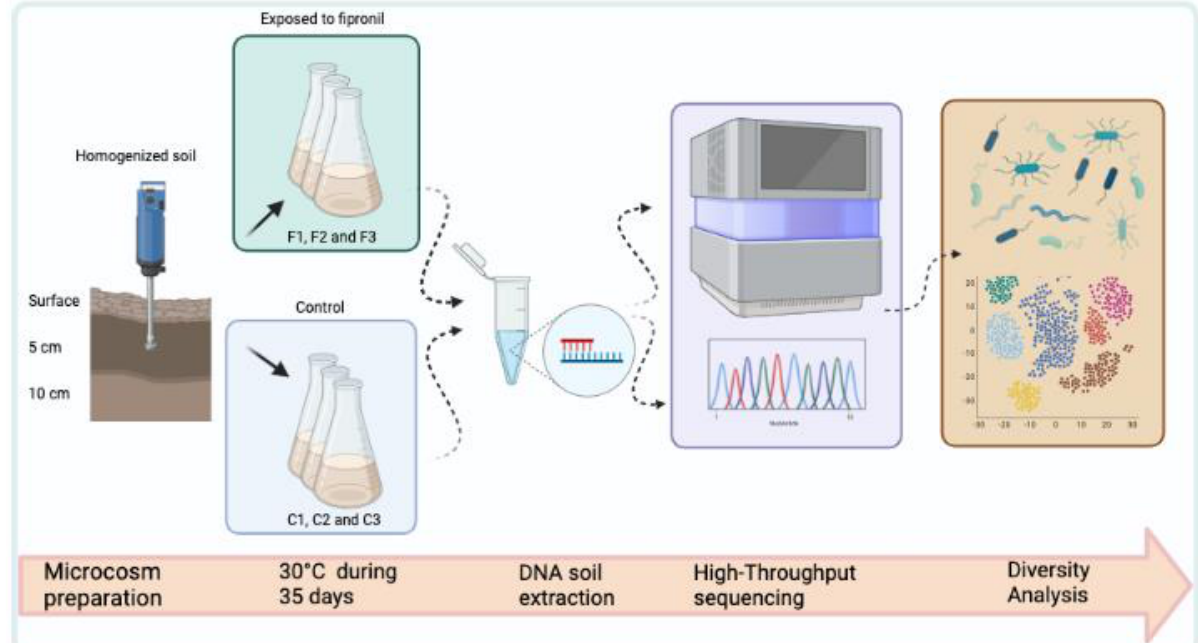
Figure 1. Schematic representation of the main steps carried out in this work.